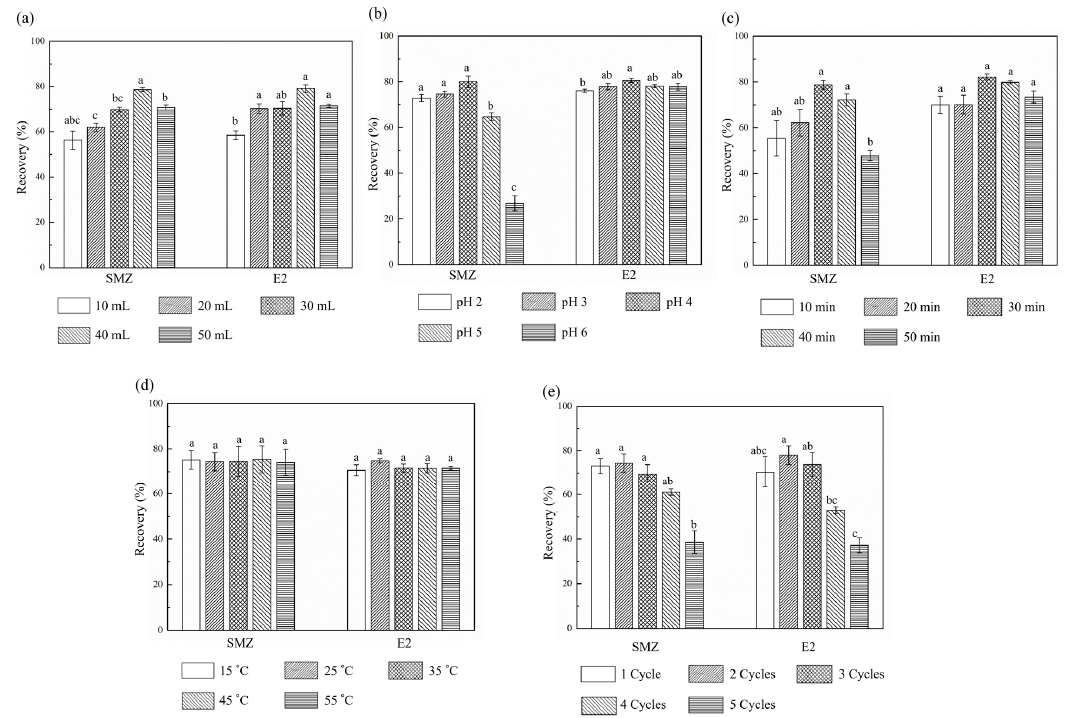
Figure 2. Influence of solution volume ( a ), pH ( b ), ultrasonication time ( c ), temperature ( d ), and extraction cycles ( e ) on SMZ and E2 recovery rates. Different letters (a, b, c) show statistically significant different means ( P < 0.05).